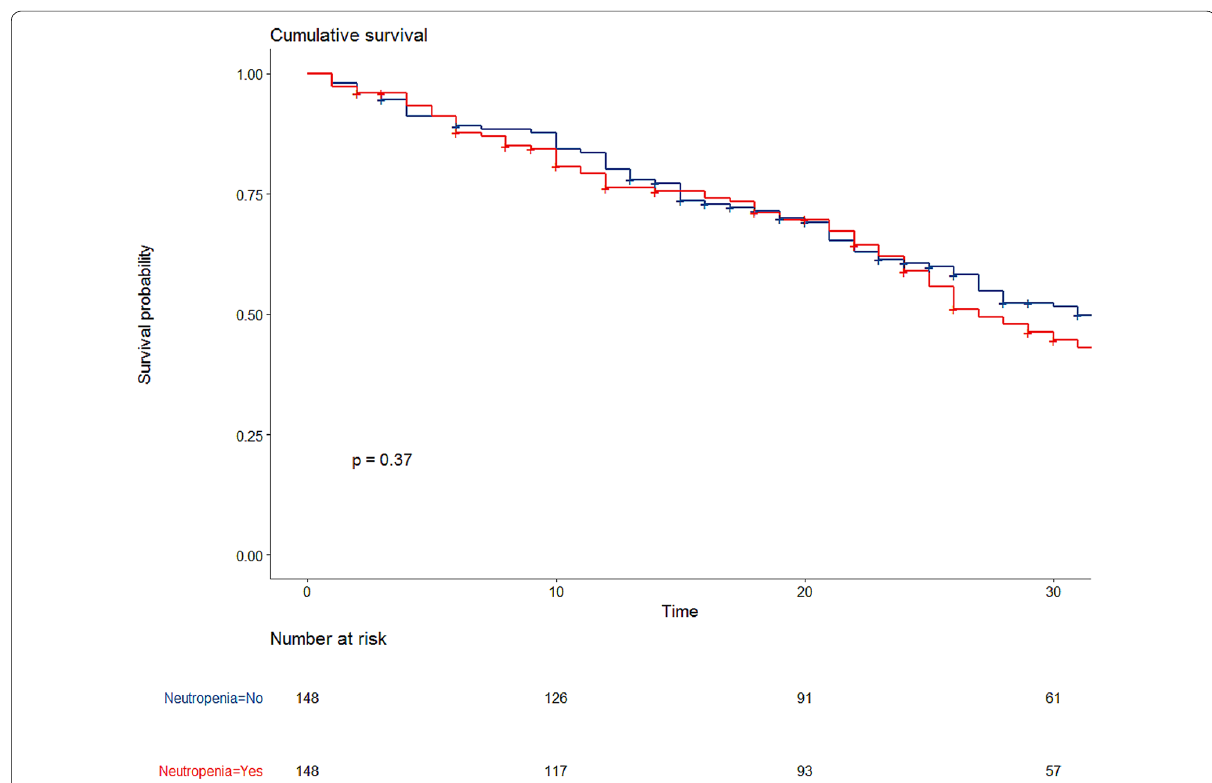
Fig. 2 Hospital survival after propensity score matching comparing 148 neutropenic patients with 148 non‑neutropenic patients (Kaplan–Meier